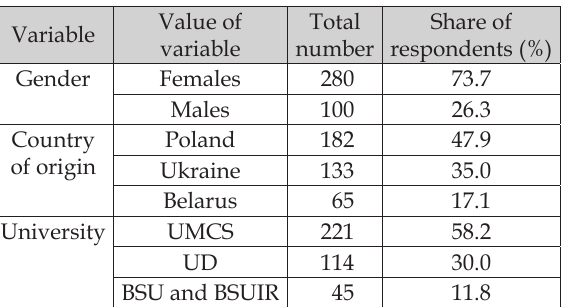
Table 1. General characteristics of respondents in Lublin, Kyiv and Minsk, n =